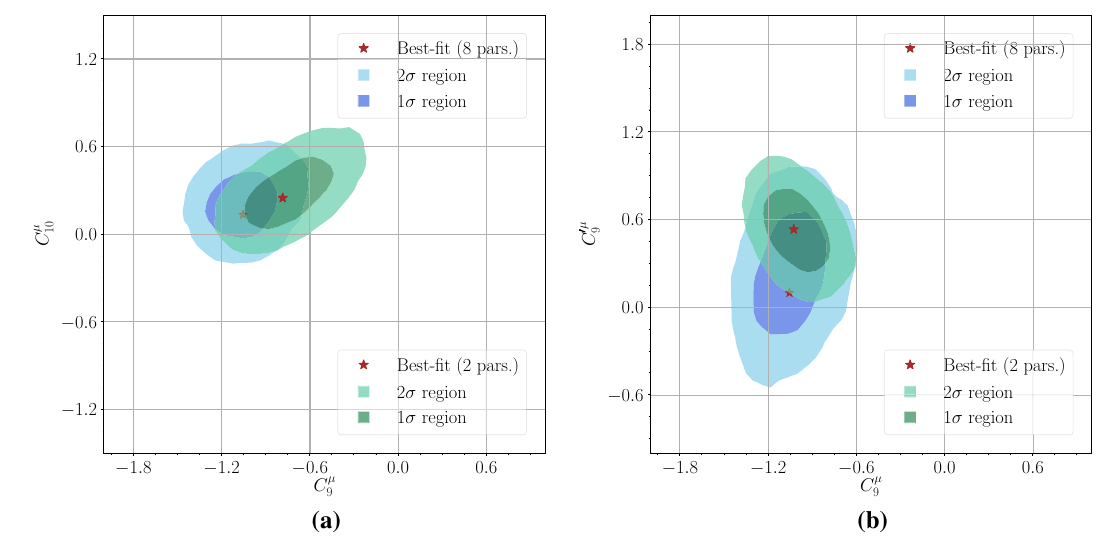
Fig. 5 a In green, the 1 σ (dark) and 2 σ (light) credible regions of the posterior pdf for the scan in the input parameters C Table 2), compared with the marginalized 2-dimensional regions in the same parameters for the scan with all 8 NP parameters floating (eighth row of Table 2), which are shown in shades of blue. The stars mark the